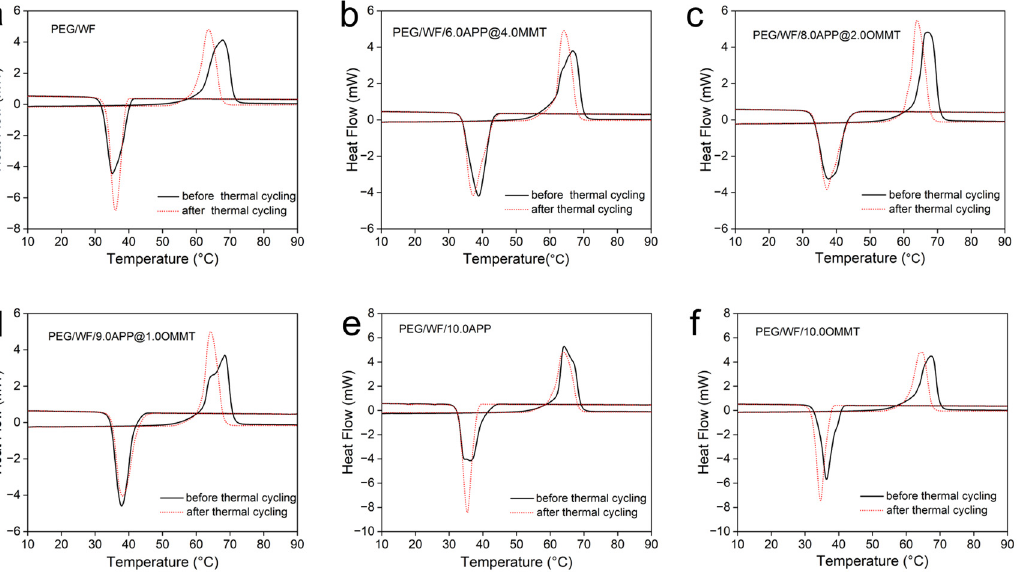
Figure 6. DSC curves of ( a ) PEG/WF, ( b ) PEG/WF/6.0APP@4.0OMMT, ( c ) PEG/WF/8.0APP@2.0OMMT, Figure 6. curves ( d ) PEG/WF/9.0APP@1.0OMMT, ( e ) PEG/WF/10.0APP and ( f ) PEG/WF/10.0OMMT composites before PEG/WF/10.0OMMT composites before and after thermal cycling. and after thermal Table 4. Latent heat storage properties of PEG/WF and its composites after thermal cycling. Sample No.